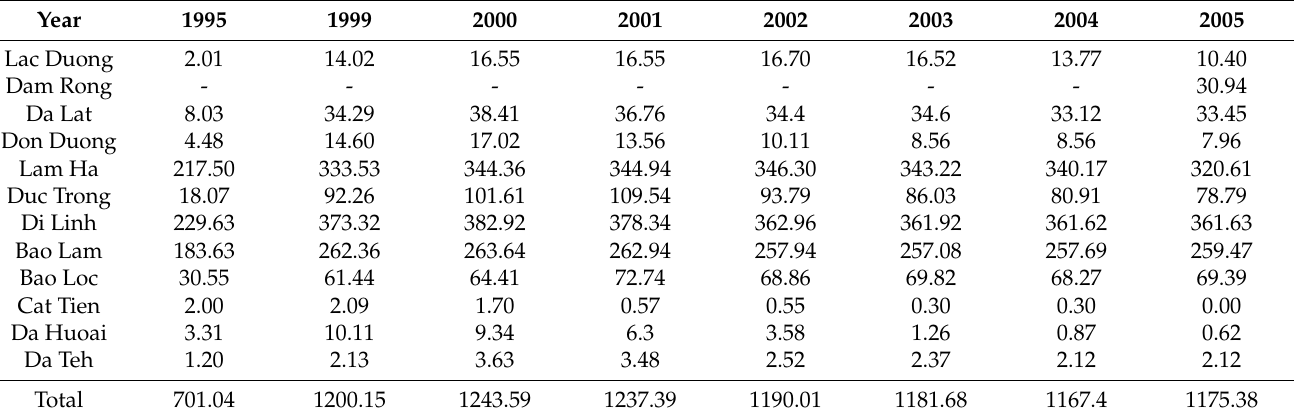
Table 1. Coffee Planted Areas by Districts in Lam Dong Province (km 2